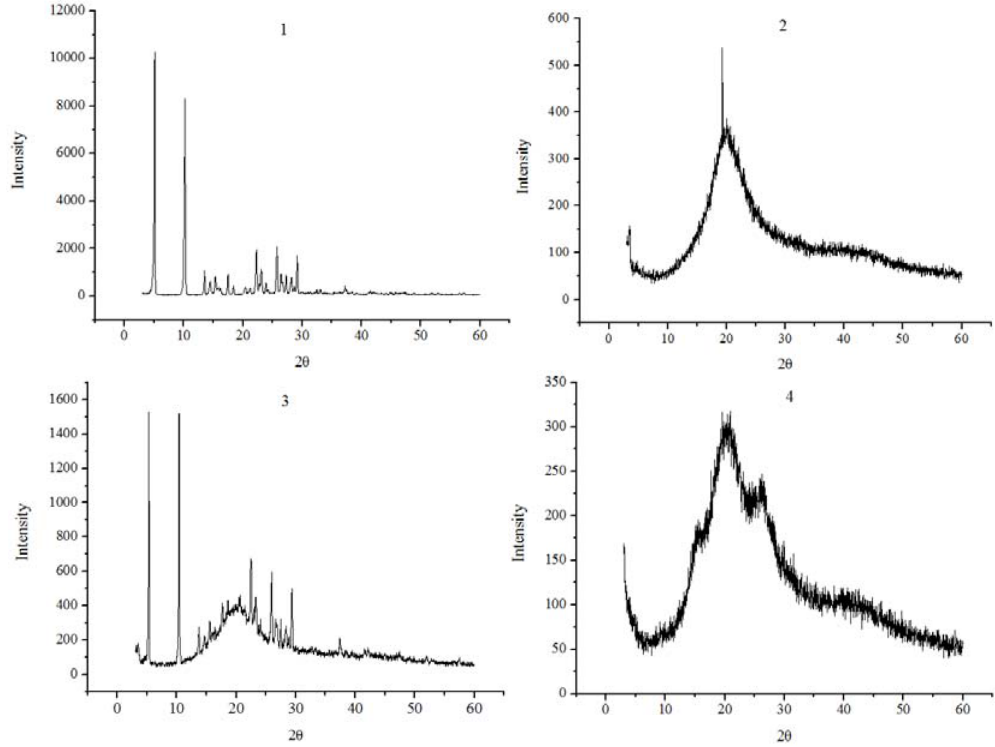
Figure 4. X-ray diffraction patterns of luteolin (1), phospholipid (2), physical mixture of luteolin and phospholipid (3), luteolin-phospholipid complex